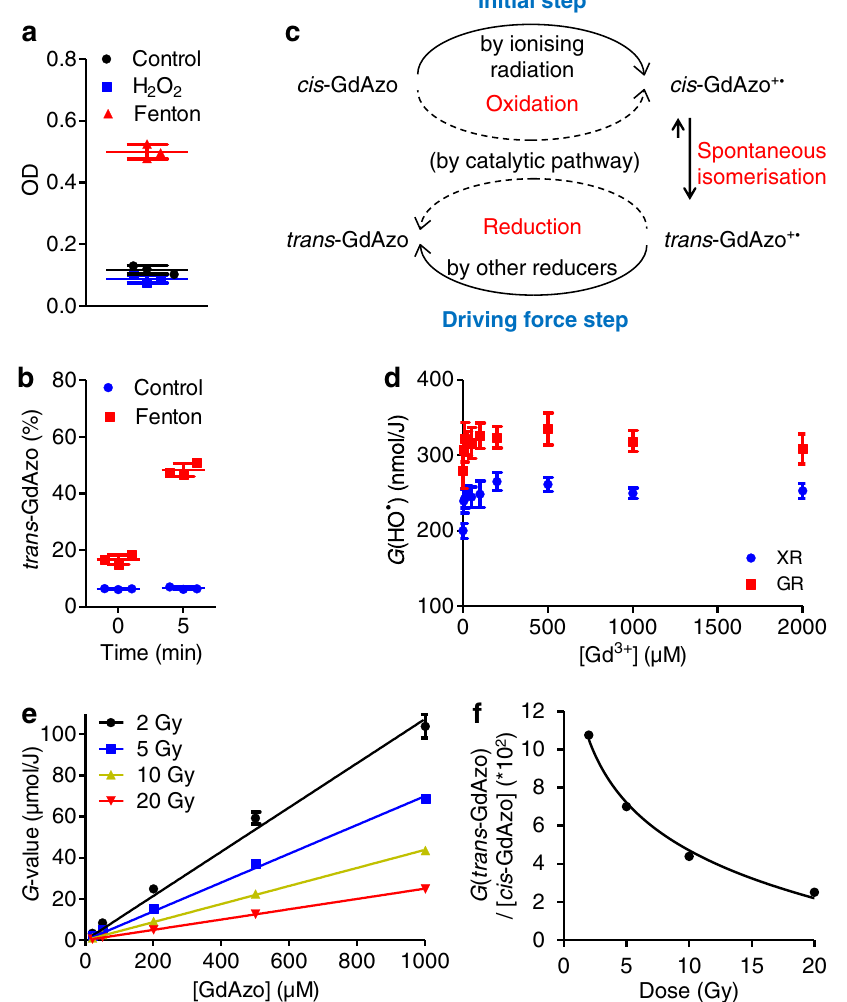
Fig. 5 Role of HO (cid:129) radicals and proposition of mechanism. a Absorbance of cis - GdAzo (photostationary state at time 0) recorded 5 min after addition of H 2 O 2 alone (bleu squares) or after running Fenton reaction (red triangle) (Control in water) ( n = 3 independent experiments). b Proportion of trans - GdAzo after running Fenton reaction (Control without Fenton reagents) in cis - GdAzo -containing medium (photostationary state at time 0, just before addition of H 2 O 2 ) determined by HPLC ( n = 3 independent experiments). An increase in trans - GdAzo from 16.7% to 48.4% was observed 5 min after H 2 O